Question: Provide a one-line summary of what is displayed.
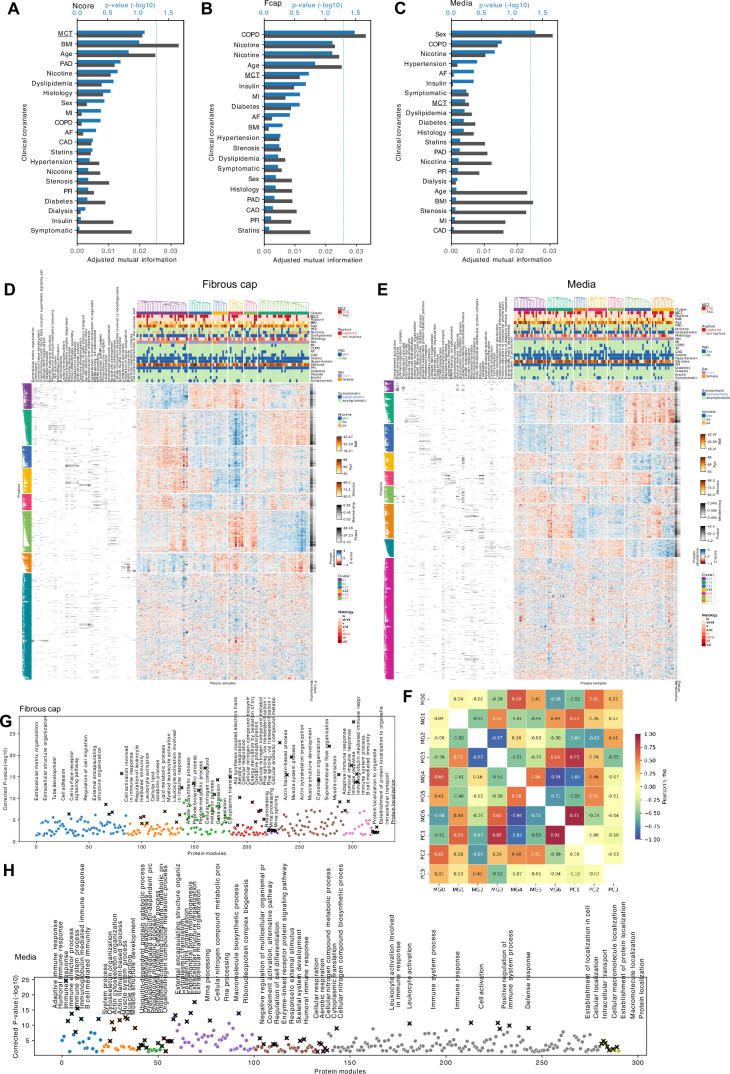
Answer: Clinical correlates of subregion subclusters and functional annotation of protein modules. A–C , Association of clinical covariates with proteome-defined subclusters in necrotic core ( A ), fibrous cap ( B ), and media ( C ), quantified by adjusted mutual information (black bars). Blue bars denote covariates reaching statistical significance after multiple-testing correction (q < 0.05; dotted line indicates the significance threshold on the −log10 scale). Among the tested covariates, significant associations were observed for COPD with fibrous-cap subclusters and sex with media subclusters. D–E , Consensus clustering of fibrous cap ( D ) and media ( E ) samples using the top 66% most variable proteins, showing subcluster structure and corresponding sample annotations. Heatmaps display z-scored protein abundances (red, higher; blue, lower) with hierarchical clustering; annotated tracks summarise clinical and histopathological metadata. F , Pairwise Pearson correlations between module-group summaries (MG0–MG6) and the leading PCs of the necrotic-core proteome (PC1–PC3), visualised as a correlation heatmap (values shown in cells). G–H , Gene Ontology enrichment of protein modules in the fibrous cap ( G ) and media ( H ), displayed as Manhattan-style plots of corrected P values (−log10). For each module, the seven most significantly enriched terms were selected for module annotation (marked by x).